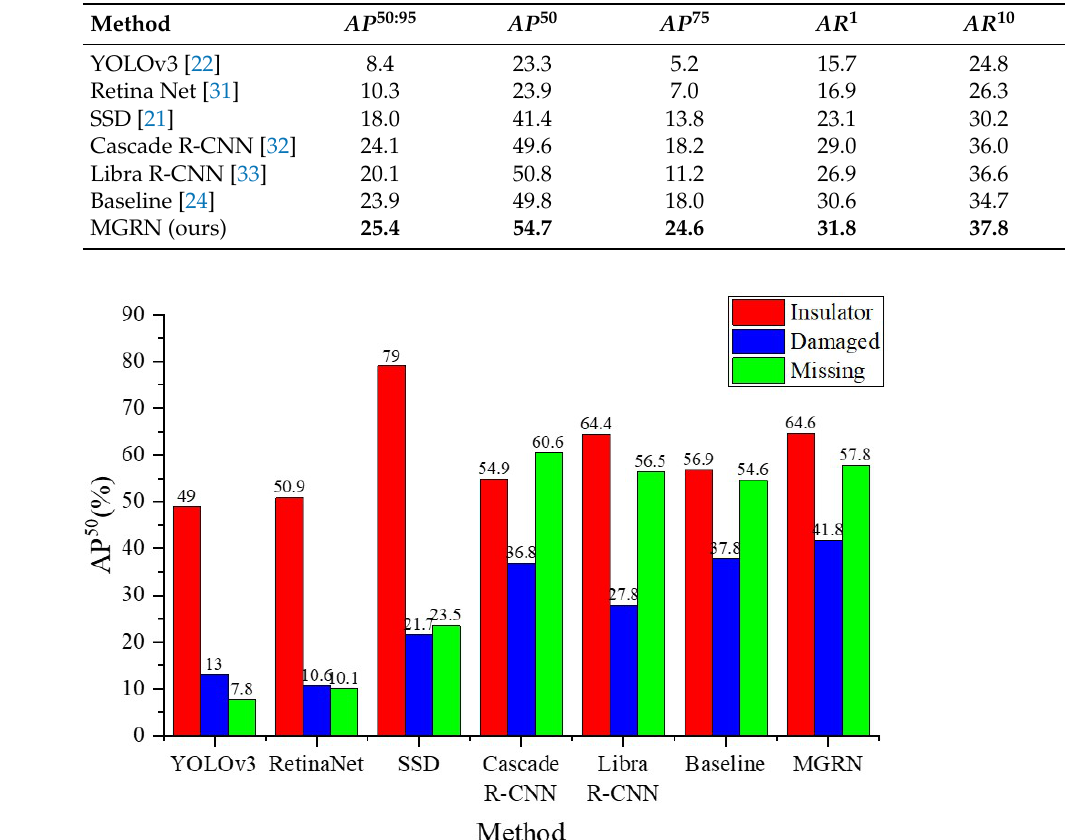
Figure 8. Comparison of defect detection results of various